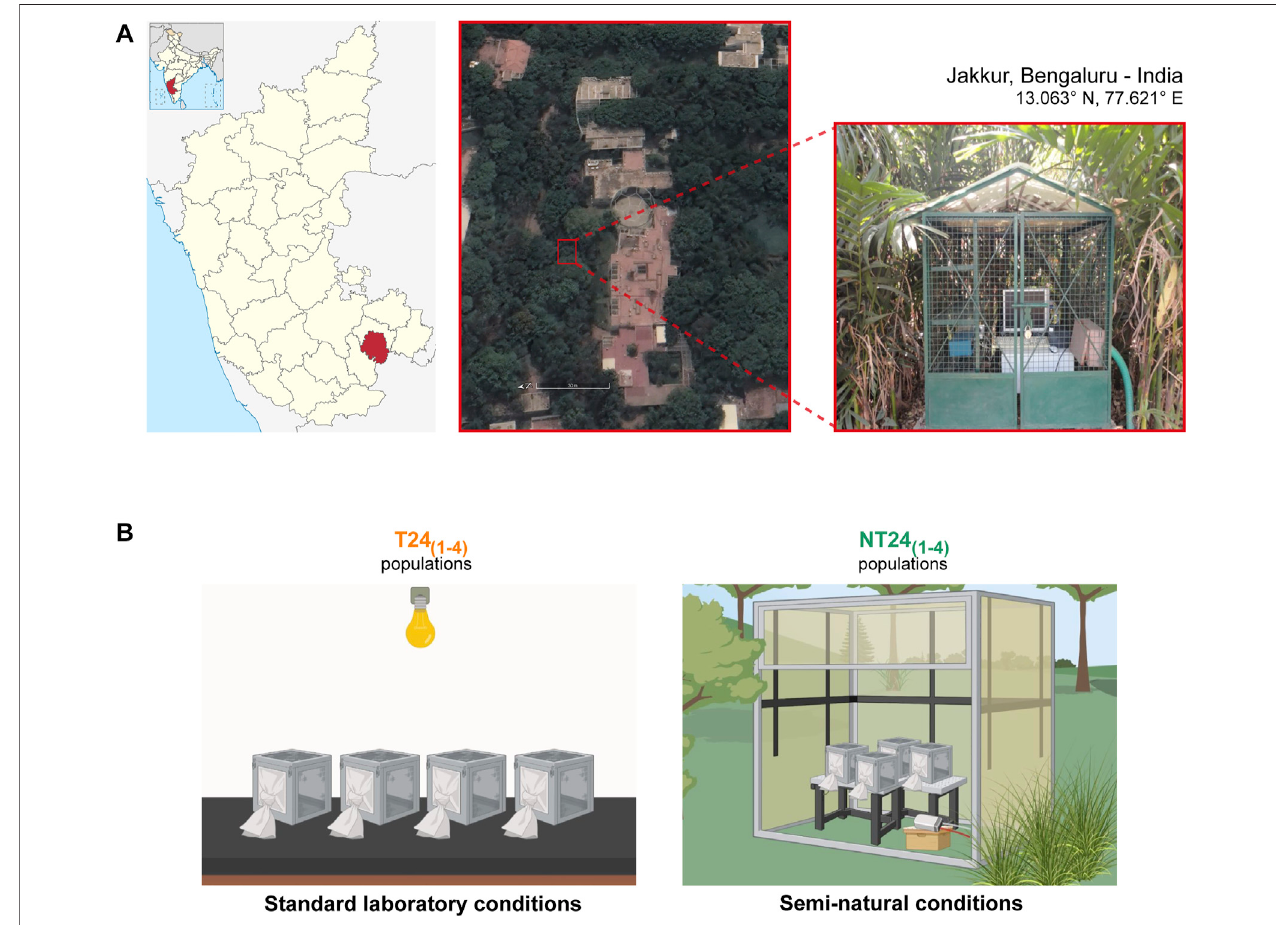
FIGURE1| Drosophilamelanogaster populations usedforthestudy. (A) Satelliteimage(left)and picture(right)ofthestudysiteandoutdoor enclosureatJNCASR institutional grounds, Jakkur, Bengaluru in India. (B) Two sets of Drosophila melanogaster populations used: T24 populations (left) were maintained under standard laboratory conditions of LD (12:12), 25 ° C, ~70% RH. NT24 populations (right), derived from T24 populations in 2013, were maintained under semi-natural conditions withnaturallyvaryingenvironmentalconditions.Adult fl iesaremaintainedinPlexiglascageswithfoodprovided adlibitum undera21-daysgenerationcycle(created using